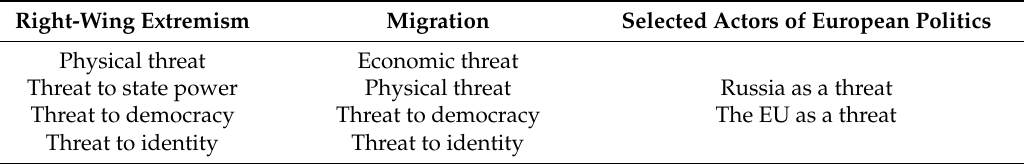
Table 1. The code